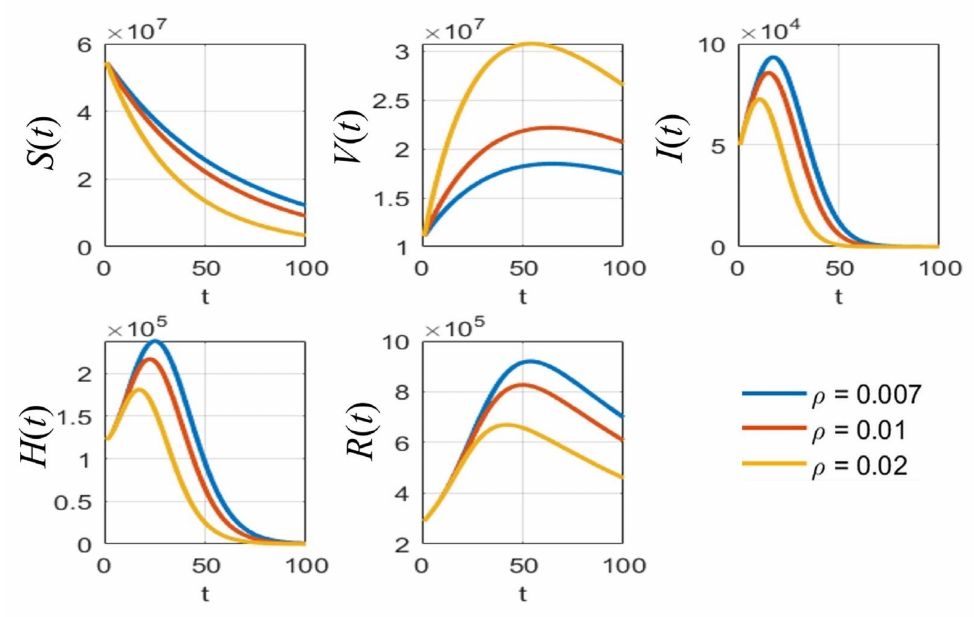
Figure 7. The simulation results of all populations compared with different vaccination rates ( ρ )